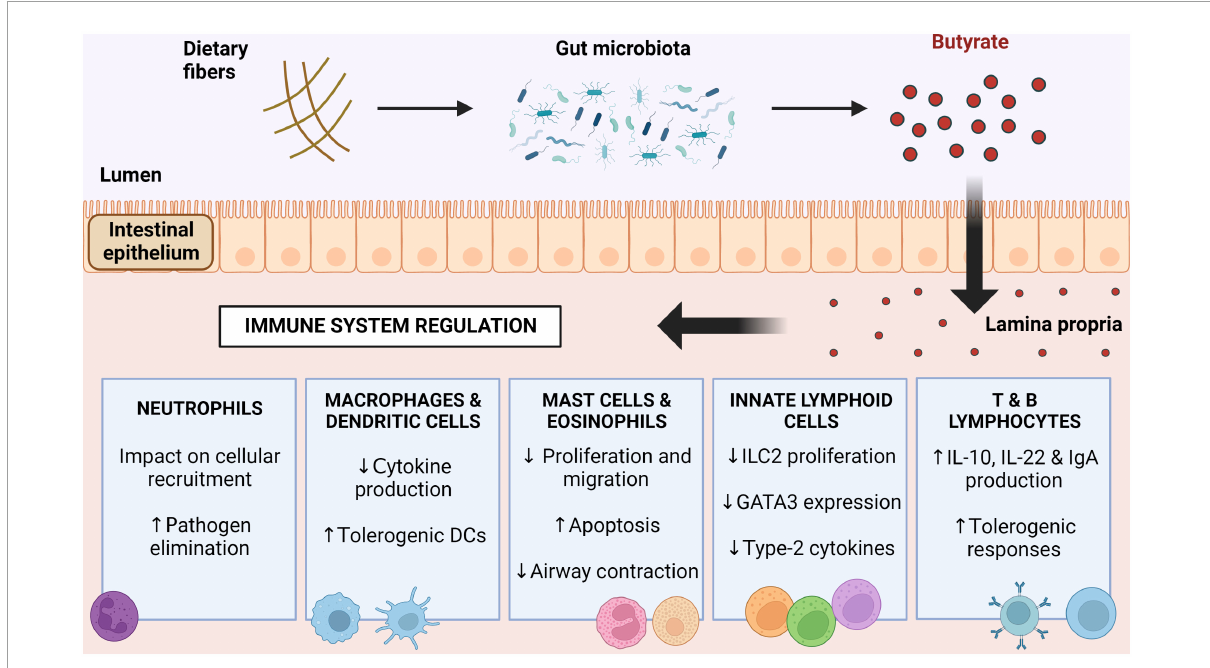
FIGURE2 Immunomodulation driven by butyrate. Butyrate produced by butyrogenic bacteria in the intestinal lumen acts on immune cells and regulates their functions. Butyrate induces neutrophil responses to pathogens, reduces cytokine production by mononuclear cells, decreases mast cell, eosinophil and innate lymphoid cell activity, and induces a tolerogenic response in lymphocytes. DCs, dendritic cells; ILC2, innate lymphoid cells type 2; GATA3, GATA binding protein 3; IL-10, interleukin 10; IL-22, interleukin 22; IgA, immunoglobulin